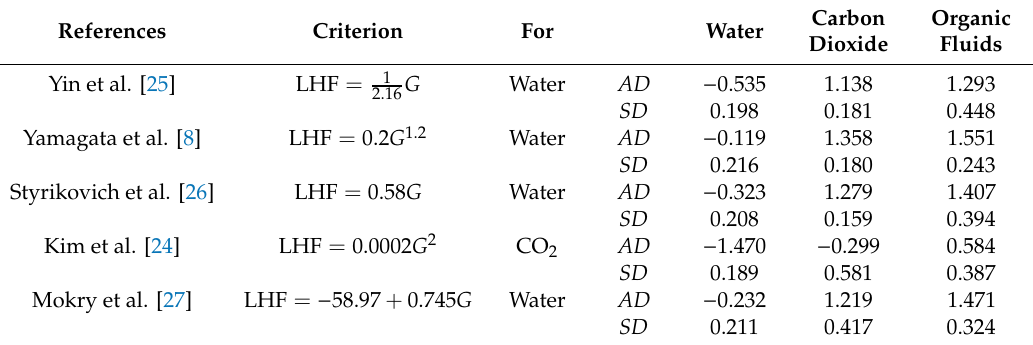
Table 2. The criteria and predicted the average deviation ( AD ) and standard deviation ( SD ) of the LHF of water and carbon dioxide [23].